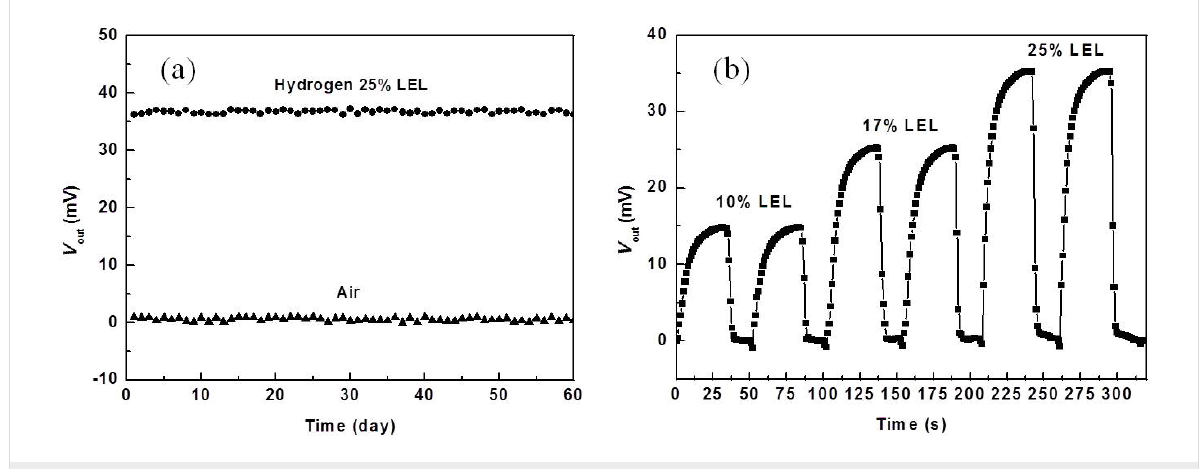
Figure 7: Stability over time of the investigated sensor as a function of (a) time and (b) in hydrogen atmosphere.